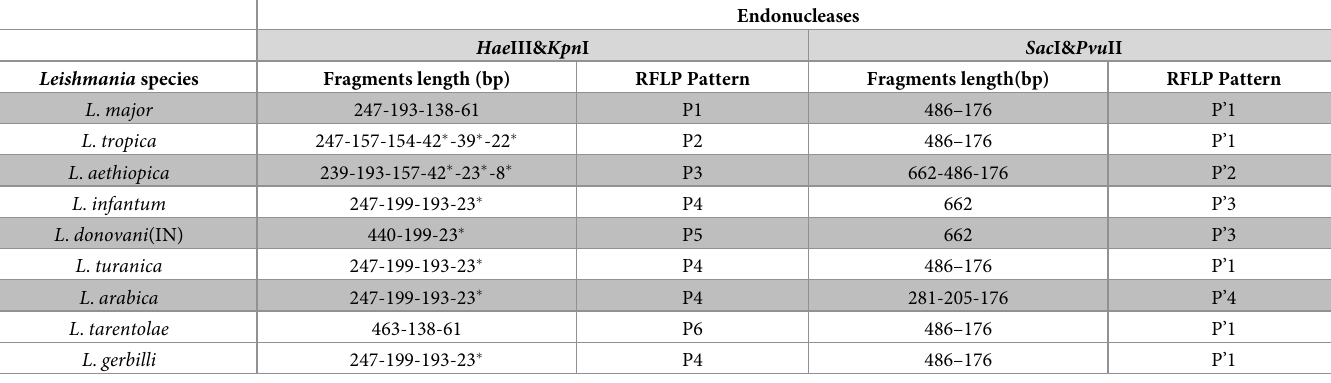
Table 1. In silico predicted restriction fragments of the DPPIII F/R PCR products of the TritrypDB database sequences. Endonucleases Hae III& Kpn I Sac I& Pvu